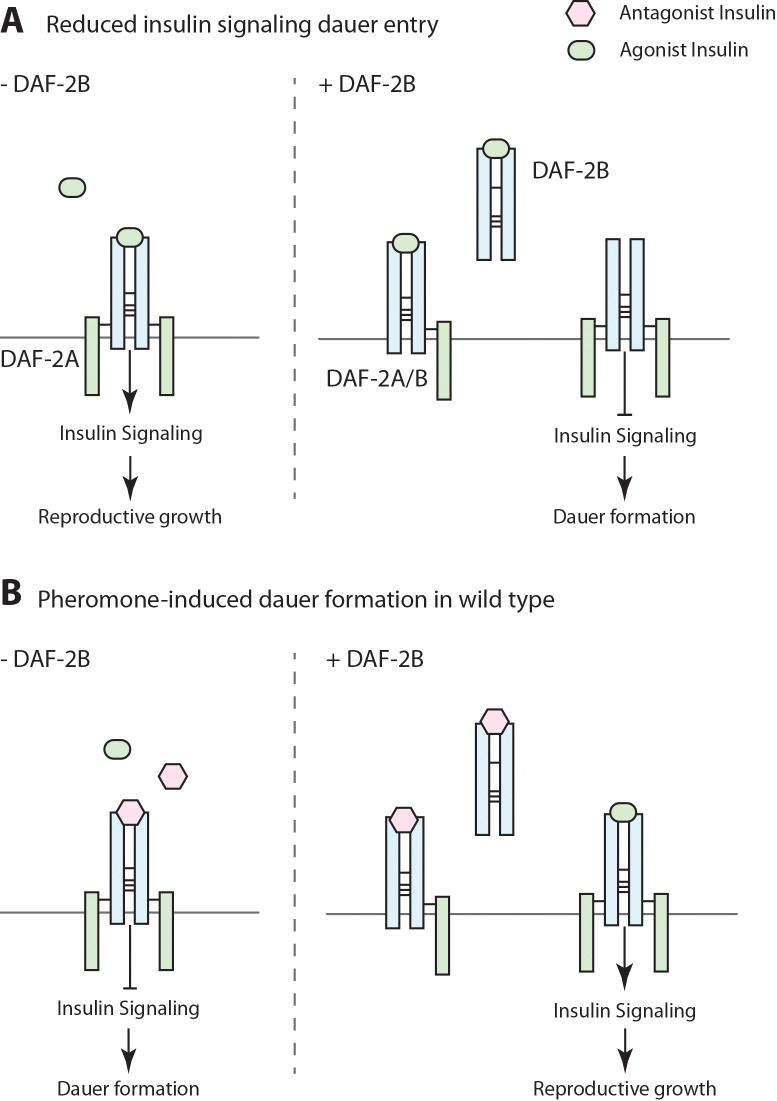
Model for the effect of DAF-2B on dauer formation.(A) In temperature-sensitive hypomorphic mutants that affect the insulin signaling pathway, such as daf-2(e1368) and pdk-1(sa709), dauer entry is driven by a reduction in agonist insulin peptides. Under these conditions, loss of daf-2b promotes reproductive growth by enhancing insulin sensitivity, while extra-copies of DAF-2B enhance dauer entry by sequestering agonist insulins. (B) Pheromone-induced dauer formation in wild type worms is driven by an increase in activity of antagonist insulin peptides. In this paradigm, loss of daf-2b enhances dauer formation. Conversely, overexpression of DAF-2B promotes reproductive growth via sequestration of insulin antagonists.